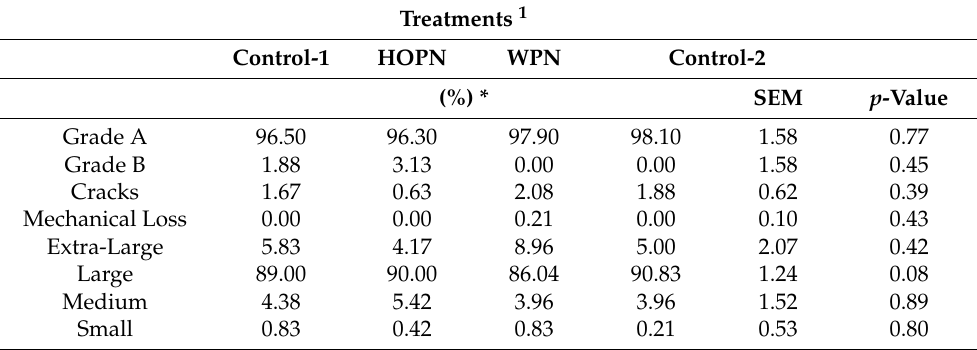
Table 5. Size and USDA grading of shell eggs produced per replicate of hens fed a control or peanut-containing diet.